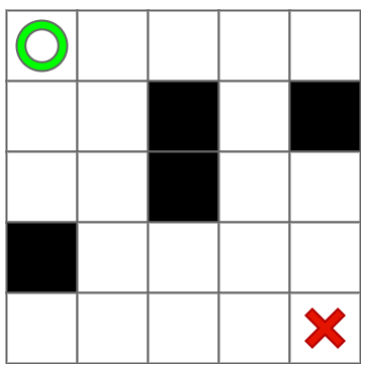
Figure 1. An example of 2D environment by grid